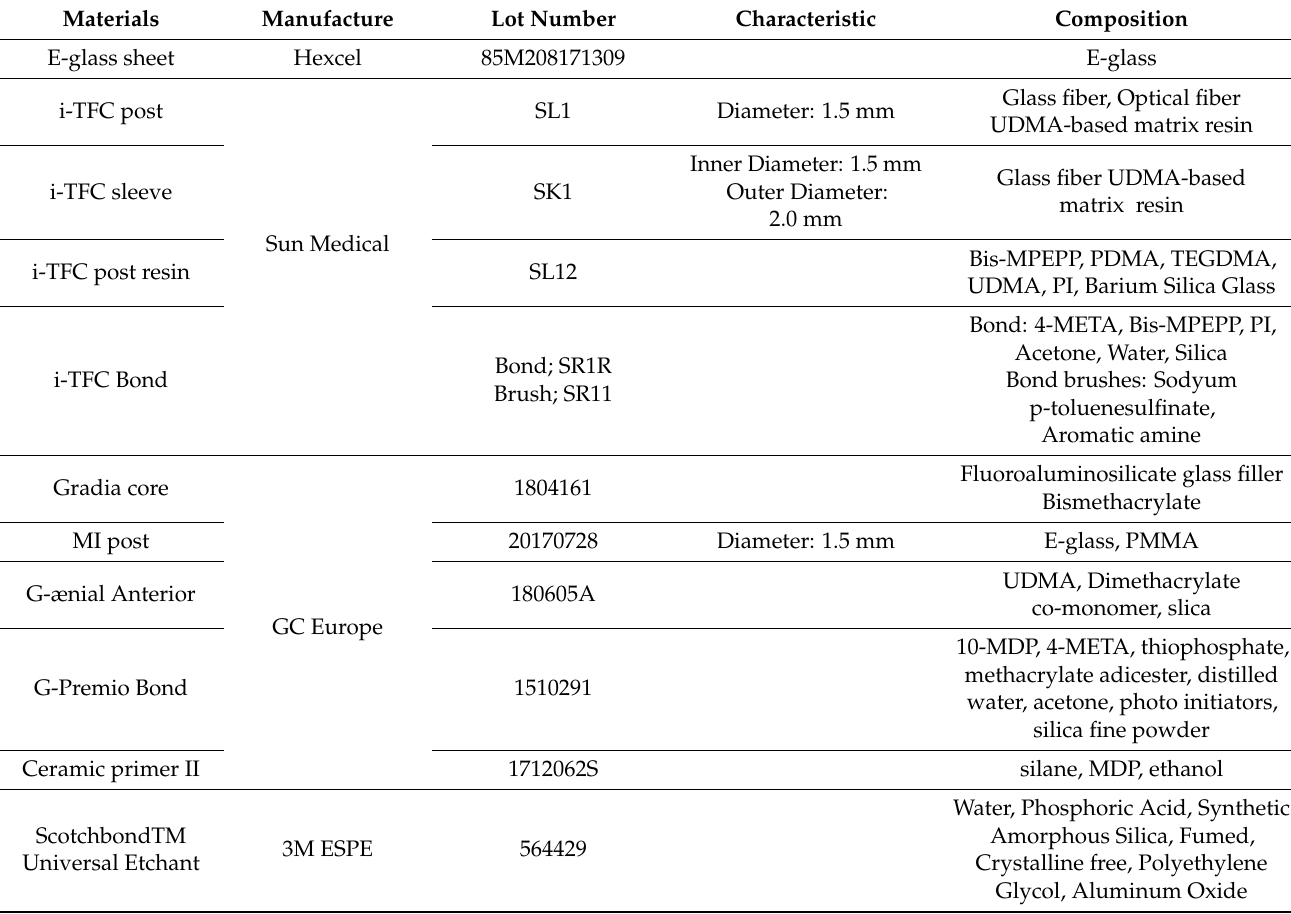
Table 1. Restorative materials used during the